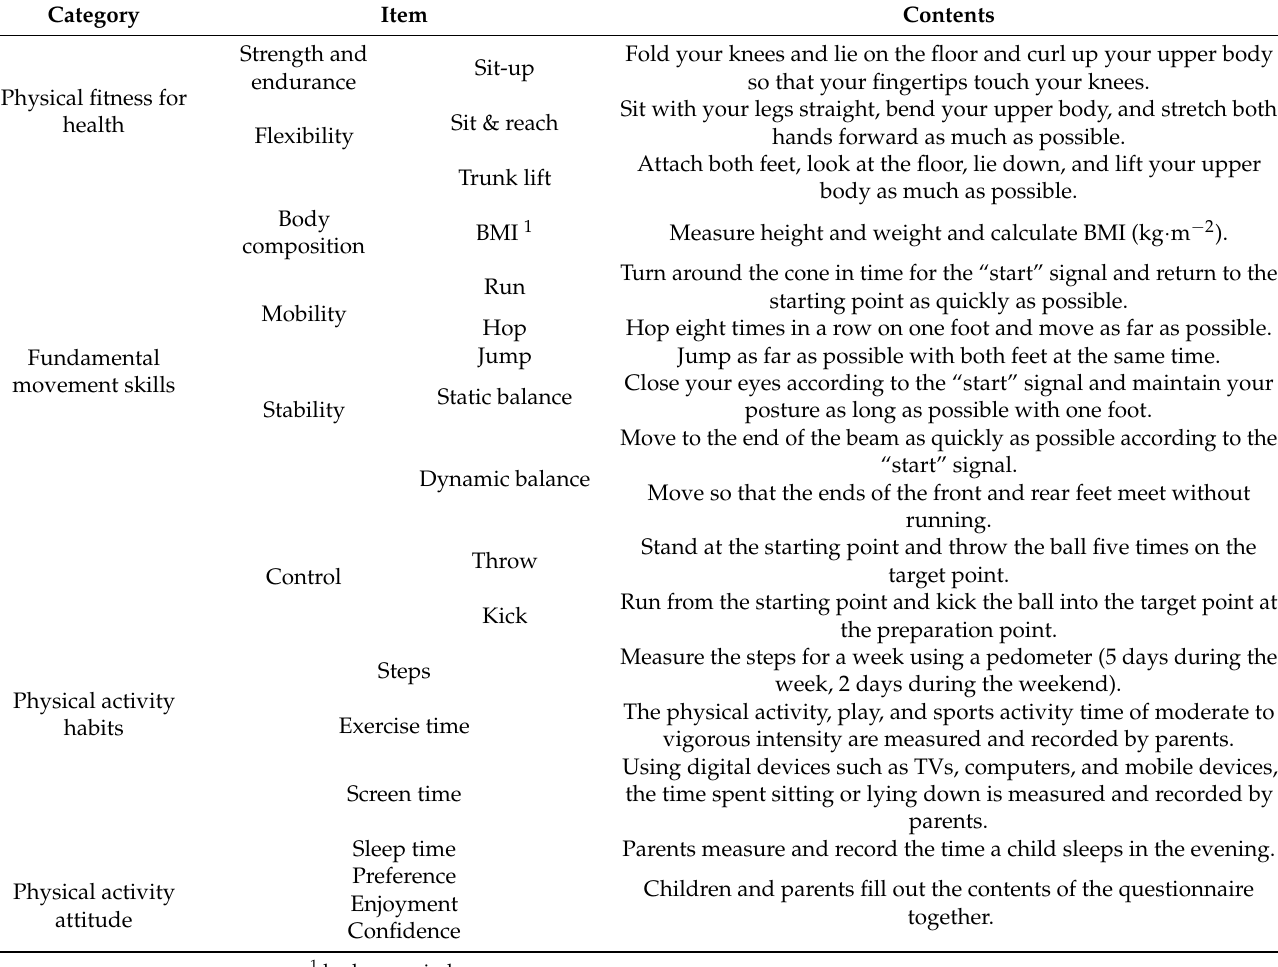
Table 6. Measurement method of children physical activity competency test